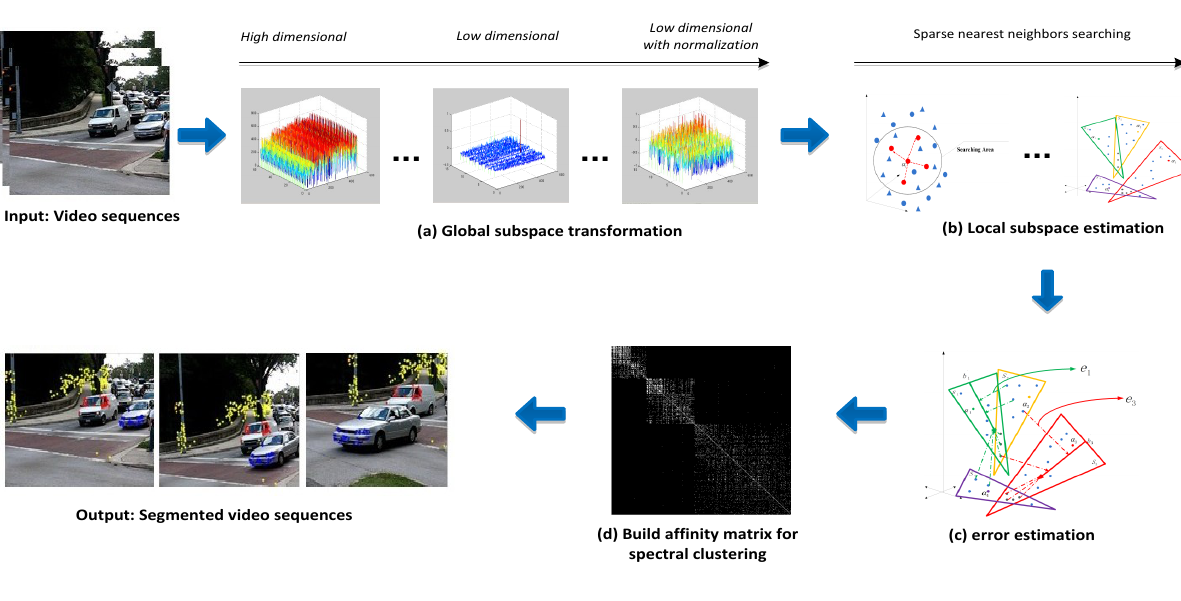
Figure 2: Overview of the proposed